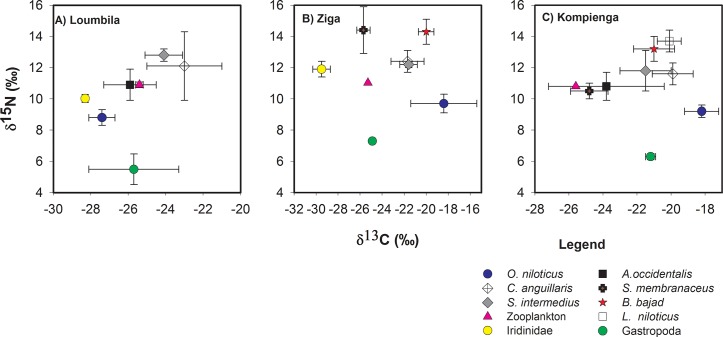
Food web structure of three freshwater reservoirs from Burkina Faso.The ratio of δ15N, indicating trophic position, and δ13C indicating dietary carbon source of biota in the freshwater reservoirs. Error bars = ± 1 standard deviation.